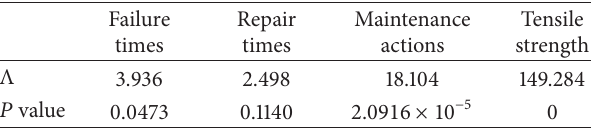
Table 3: The LRT and 𝑃 value for the four data